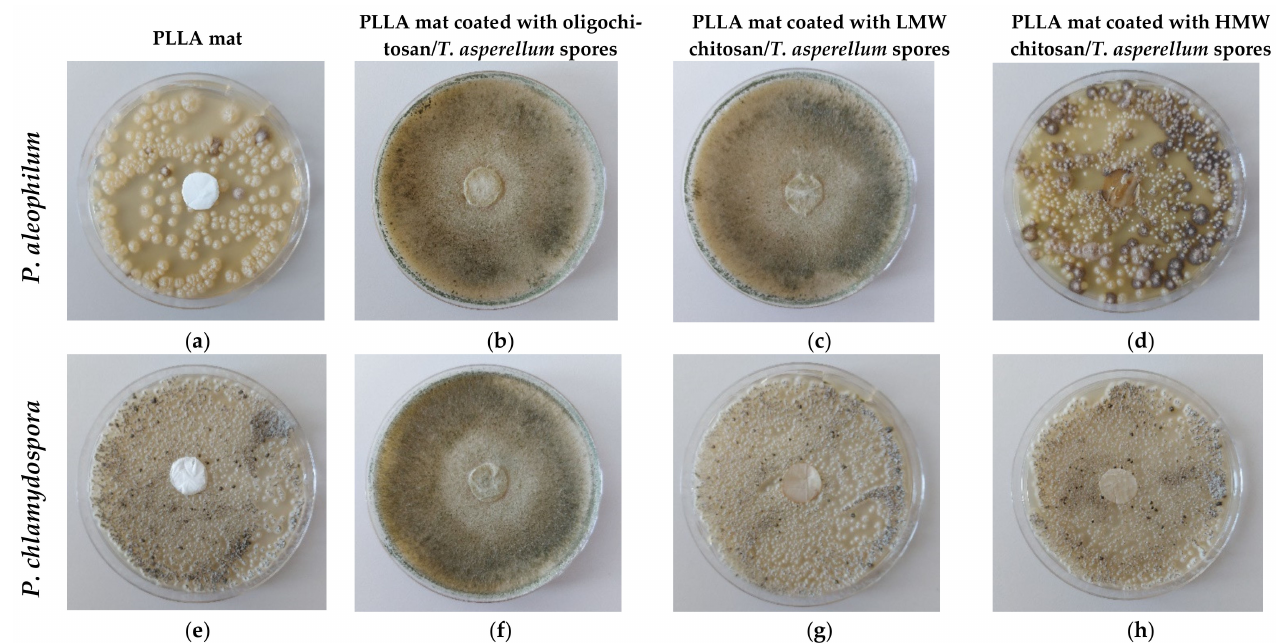
Figure 6. Digital images of the behavior test of the mats against P. aleophilum ( a – d ) and P. chlamydospora ( e – h ): ( a , e ) a PLLA mat; ( b , f ) a PLLA mat coated with oligochitosan/ T. asperellum spores; ( c , g ) a PLLA mat coated with LMW chitosan/ T. asperellum spores; and ( d , h ) a PLLA mat coated with HMW chitosan/ T. asperellum